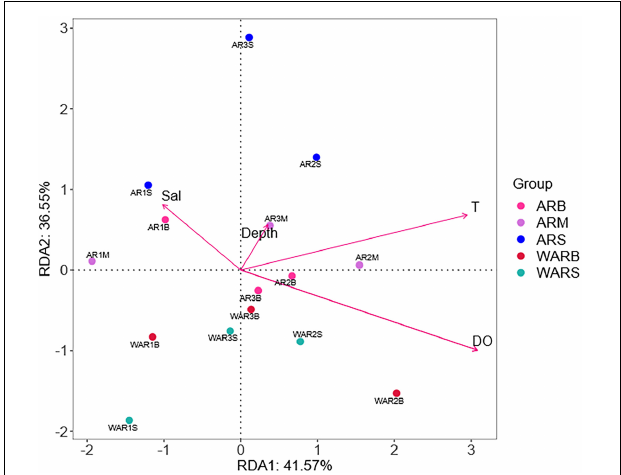
FIGURE 7 | Redundancy analysis (RDA) based on the Bray–Curtis dissimilarity matrix. Numbers represent sample names; different colors represent sample groups in different sampling locations; arrows represent environmental factors; the angles between environmental factors represent positive and negative correlations between environmental factors (acute angle: positive correlation; obtuse angle: negative correlation; right angle: no correlation); and the closer the projection points and arrows are, the closer the relationship between the sample and the environmental factor is. The closer the projection points are, the more similar the attribute values of the environmental factors among samples are; that is, the environmental factors have the same influence on the